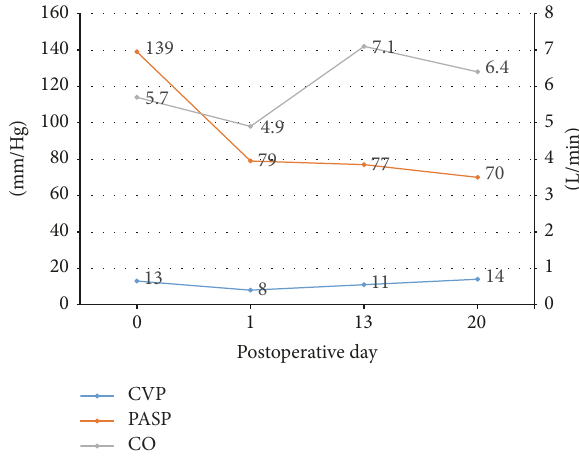
Figure 2: Graph representing changes in pulmonary artery systolic pressure, cardiac output, and central venous pressure after initiation of extracorporeal membrane oxygenation. CVP, central venous pressure; PASP, pulmonary artery systolic pressure; CO, cardiac